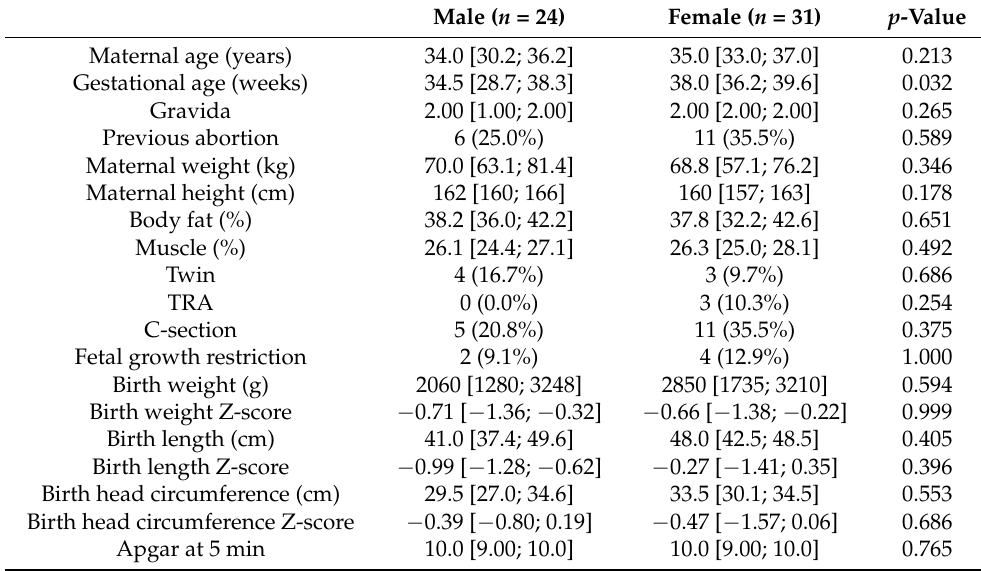
Table 1. Maternal and neonatal characteristics according to neonatal sex; data from Spain between